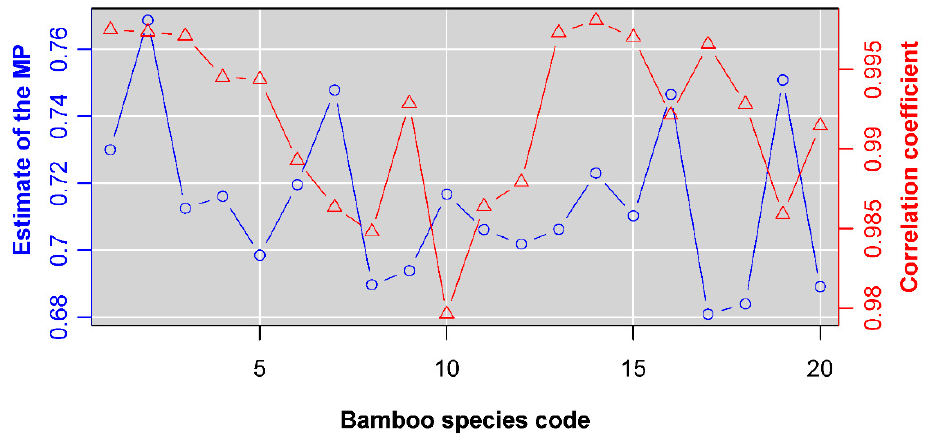
Figure 3. The estimates of the Montgomery parameters (MP) and the correlation coefficients for 20 bamboo species. Blue open circles represent the estimates of the MP; and red open triangles represent the correlation coefficients. The number on the x -axis represents the bamboo species code (see Table S1 in the online Supplementary Materials for details).